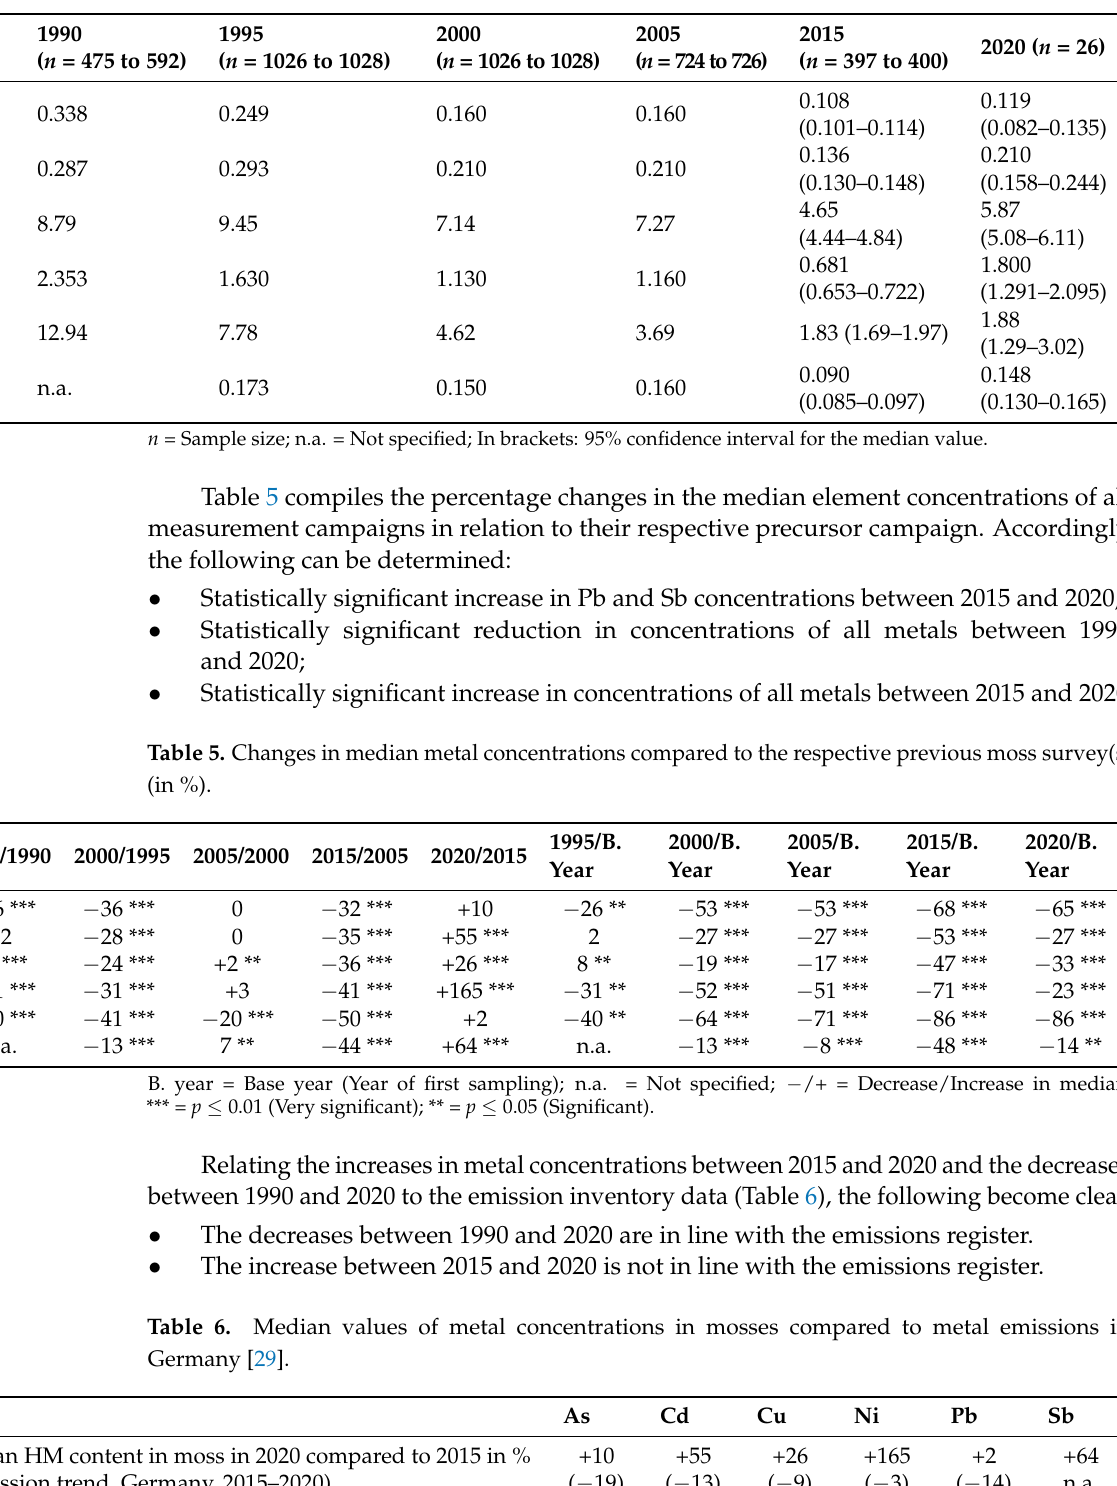
Table 4. Median values of metal concentrations in mosses collected between 1990 and 2020.